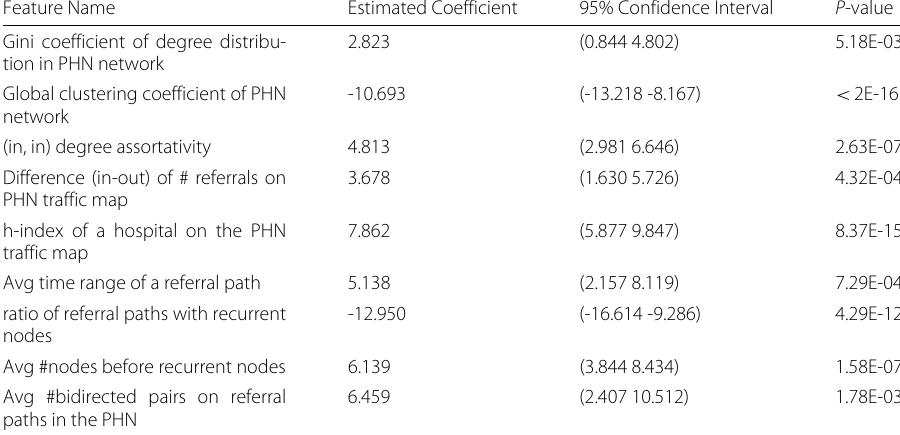
Table 10 Significant predictors in Logistic Regression for COTH